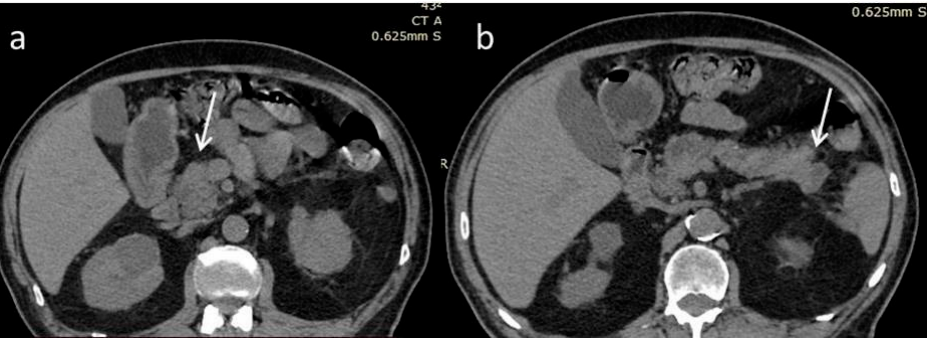
Figure 1. Non-enhanced computed tomography scan (NECT). Hypodense, poorly defined masses at the head ( a ) and tail ( b ) of the pancreas (white arrows).